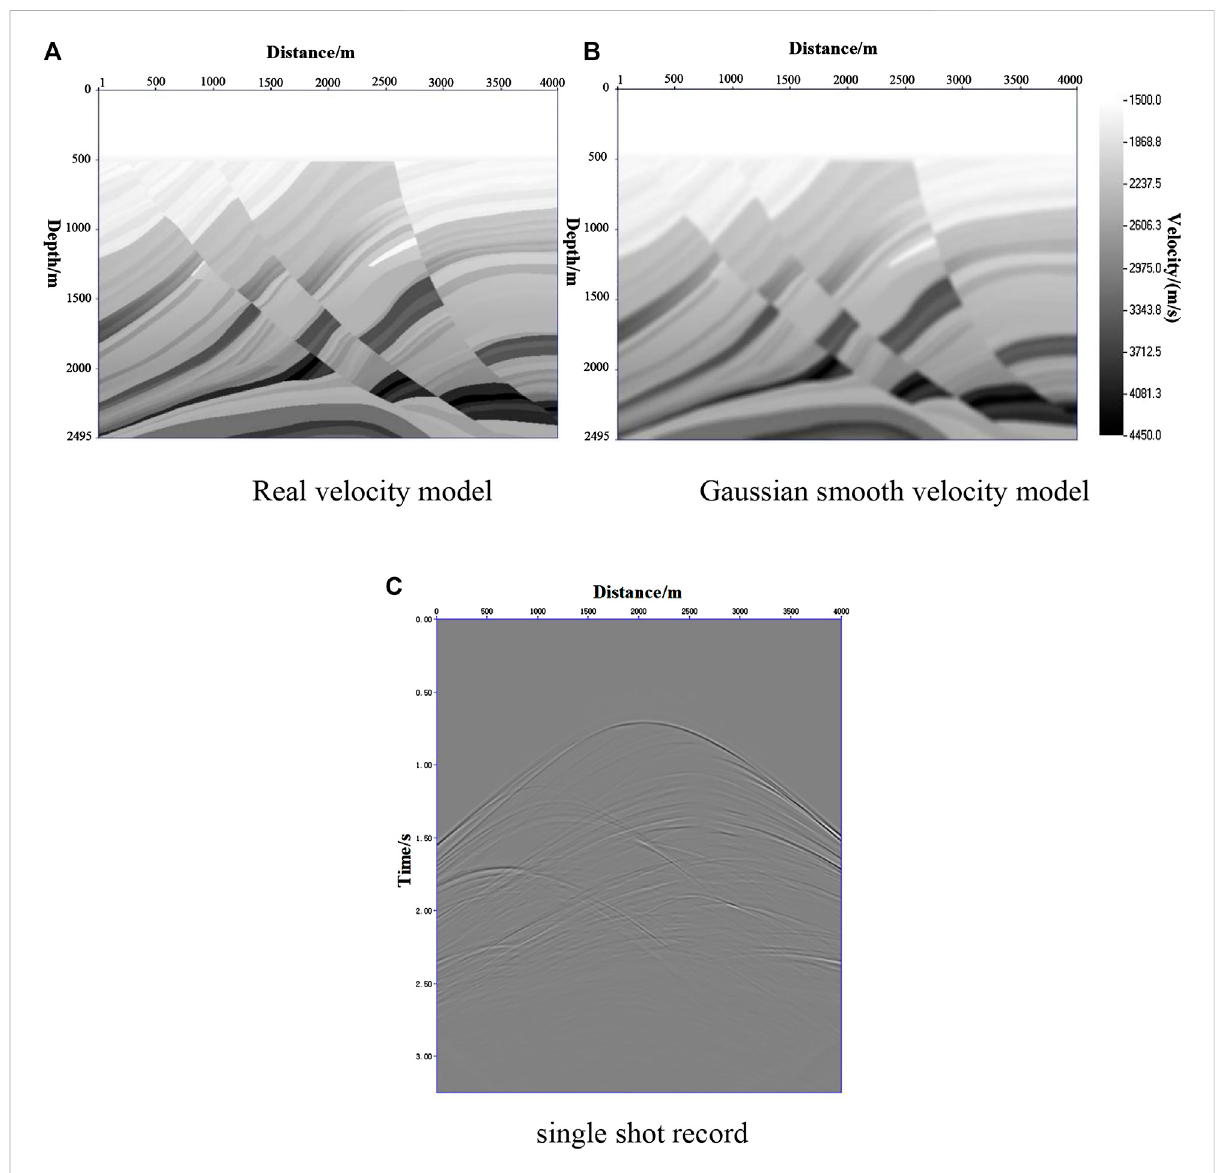
FIGURE 3 Velocity fi eld and single-shot record of the Marmousi model. (A) real velocity model; (B) Gaussian smooth velocity model; (C) single-shot